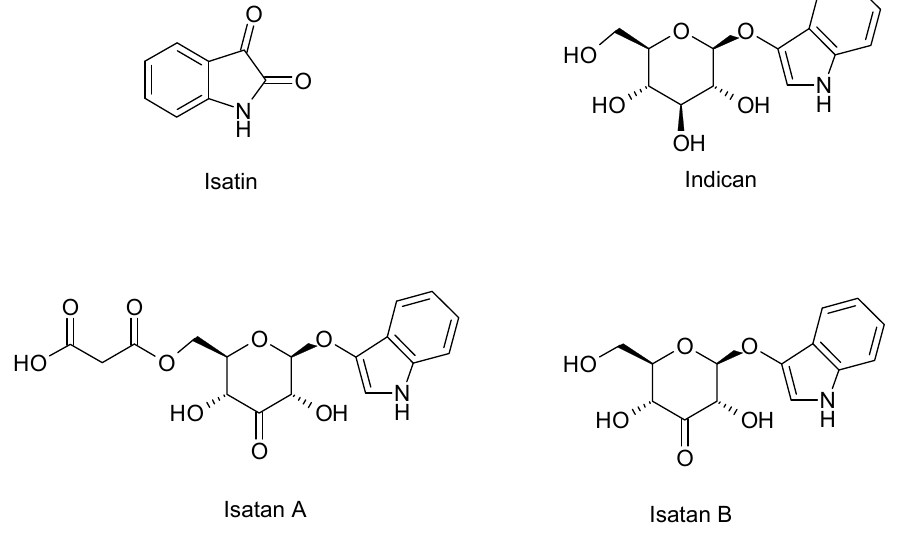
Figure 2. Chemical structure of indigo precursors.